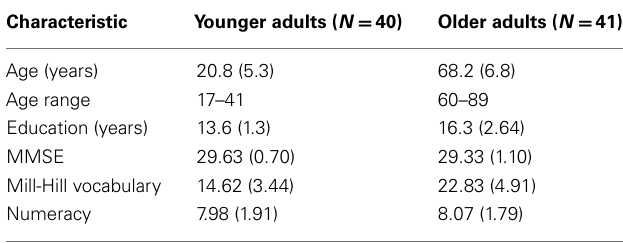
Table 1 | Participant characteristics, by age